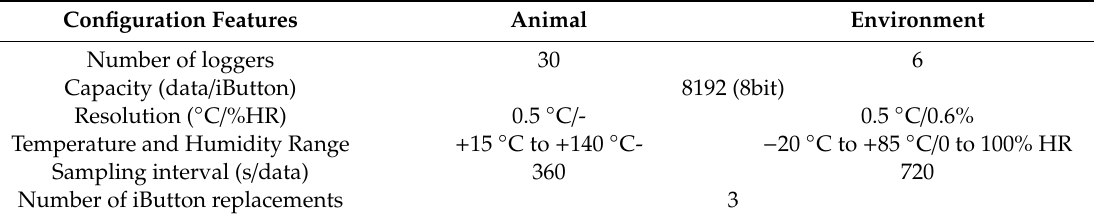
Table 2. Configuration used in the iButton DS1922E & DS1923 loggers.